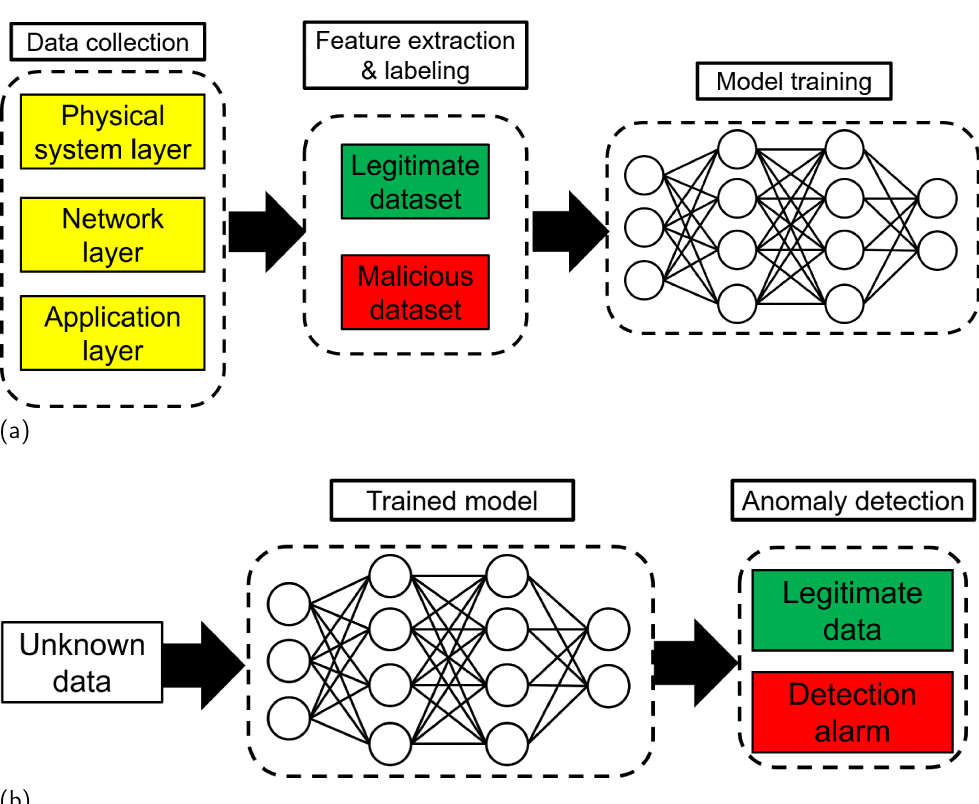
Figure 6. Machine learning in cyber-physical attack detection: ( a ) training the ML model for anomaly detection, and ( b ) anomaly detection with unknown